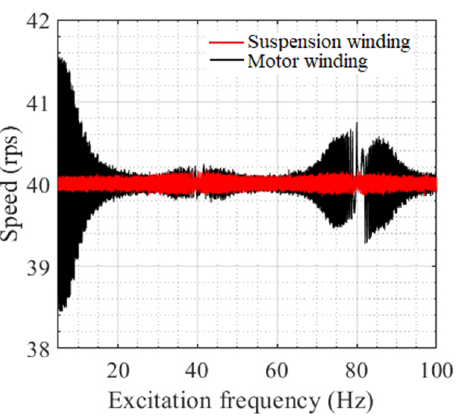
Figure 11. Rotational speed with and without injection of the alternating d-axis current.